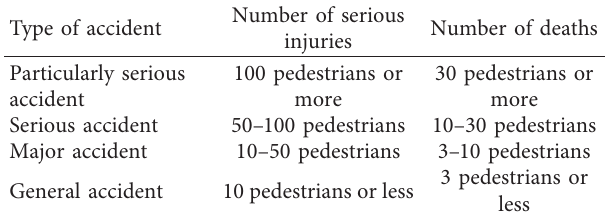
Figure 26: Schematic diagram of each exit. Table 19: Accident level classification.